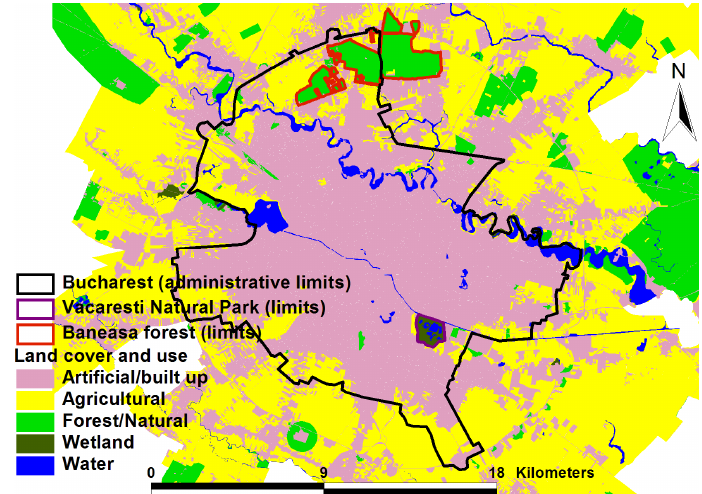
Figure 3. Position of the two Romanian case studies in Bucharest (administrative limits shown with a black a contour) in the land use context. The limits of the Vacaresti Nature Park are displayed using a purple contour (bottom part of image, close to the center), and those of the B ă neasa Forest are displayed with a red contour (top center).